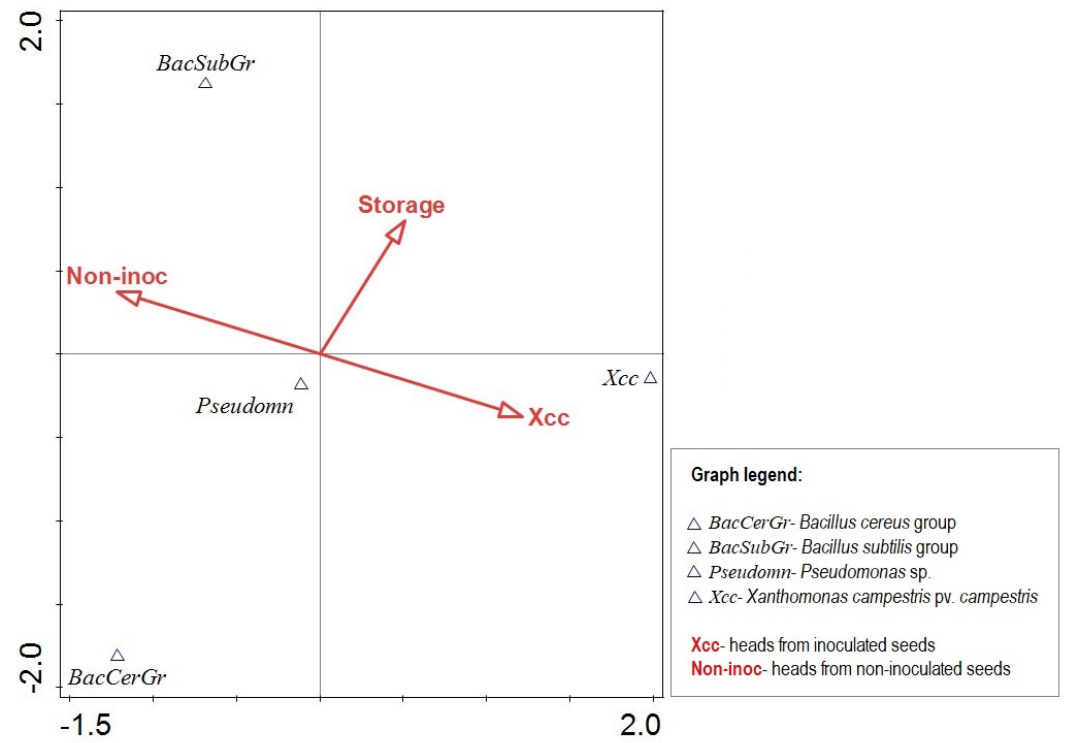
Figure 4. CCA ordination diagram shows the relationships between the presence of the bacterial genera and two factors including the time point of sampling (at the harvest and after storage) and the artificial inoculation with